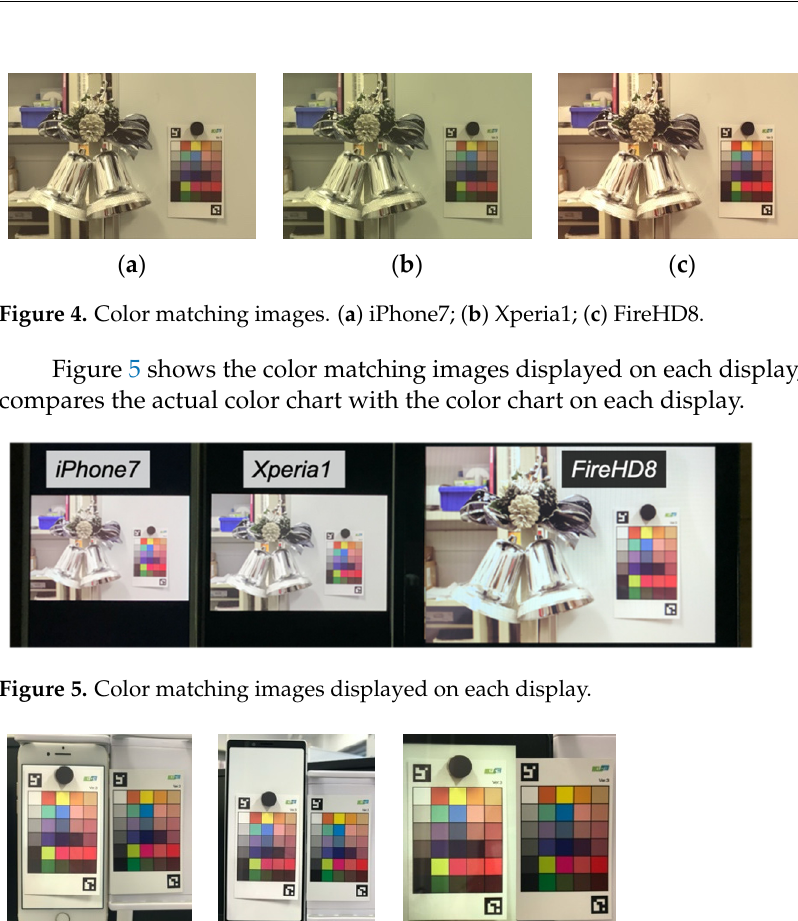
Figure 6. Comparison of the actual color chart and that on each display. ( a ) iPhone7; ( b ) Xperia1; ( c ) FireHD8.